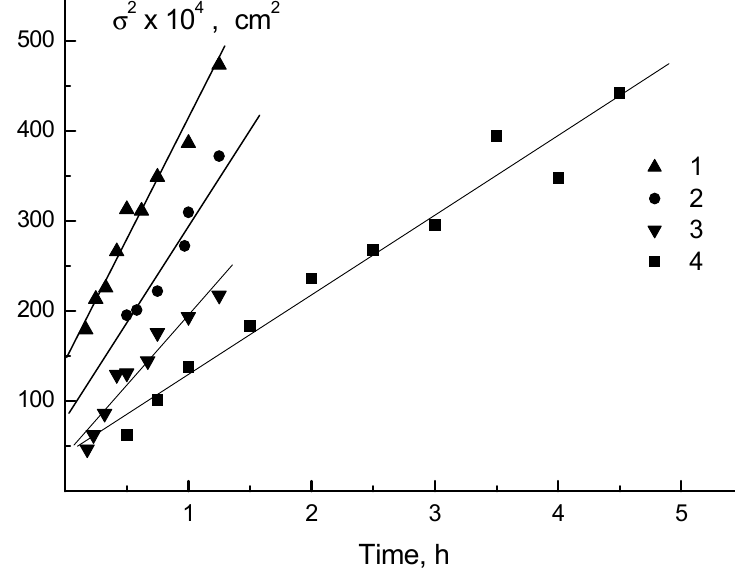
Figure 2. Time dependences of the dispersion of diffusion boundary σ 2 for DGL G1 (1), G2 (2), G3 and G4 in DMF at solute concentration of 0.04 × 10 − 2 g · cm − 3 and at 298 K. The dispersion values were calculated from the maximal ordinate and the area under the diffusion